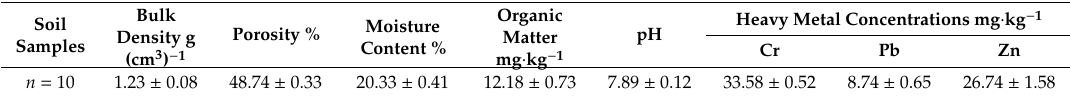
Table 1. Mean and standard deviation (SD) (mean ± SD) of soil properties of the experimental sites in